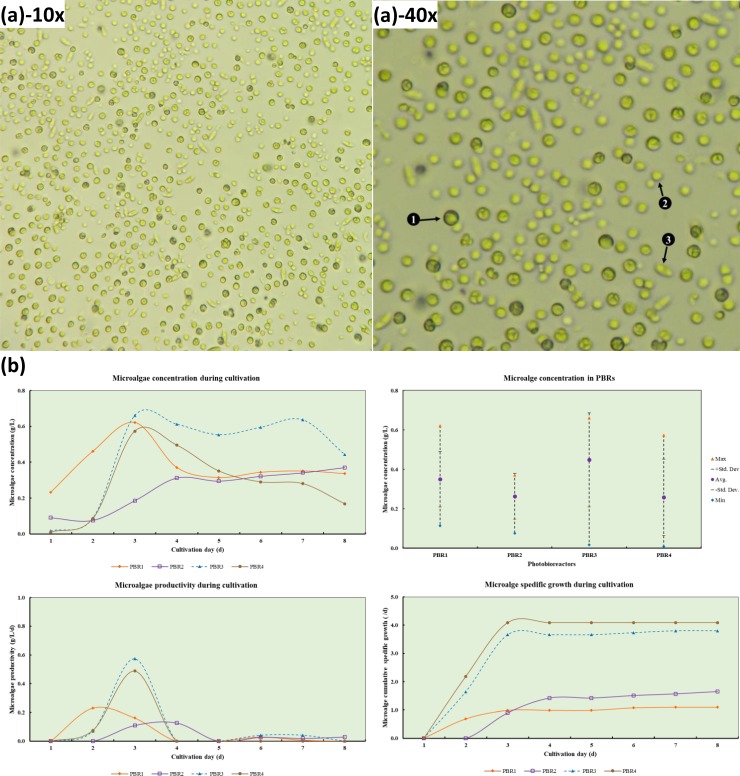
Microalgae species as observed under the light microscope and monitoring data during cultivation.(a) Co-culture microalgae species, as seen on day 6 (10x –left, 40x-right (1—Chlorella vulgaris, 2—Chlorella sorokiniana, and 3—Scenedesmus simris002)). (b) Microalgae concentration during cultivation and within PBRs; and productivity and specific growth rate during eight (8) days of cultivation.